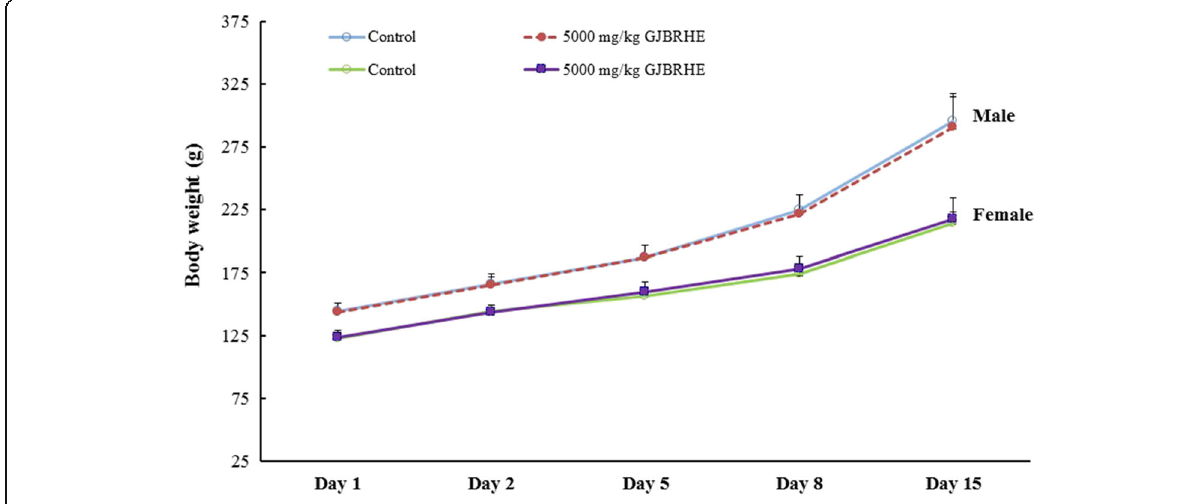
Fig. 2 Mean body weight changes after administration of GJBRHE